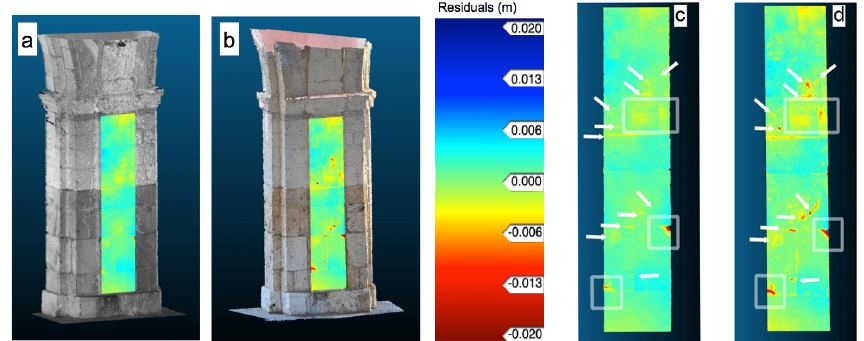
Figure 6. Geometrical anomalies of the columns: the colors represent the residuals in meters inferred by the geometrical anomalies of the aggregated point cloud with respect to a fitted plane. Left side of the figure: (a) from TLS survey (b) from DCI photogrammetric survey. Right side of the figure: (c) geometrical anomalies only by TLS survey; (d) overlapping of the TLS survey and the DCI photogrammetric survey. The similarities are highlighted by the white arrows and the box, the anomalies are more perceivable thanks to the overlapping of the two techniques. This result indicates that the combination of the different methodologies can improve the detection of defective parts (JRC 3-D Reconstructor ® , CloudCompare).